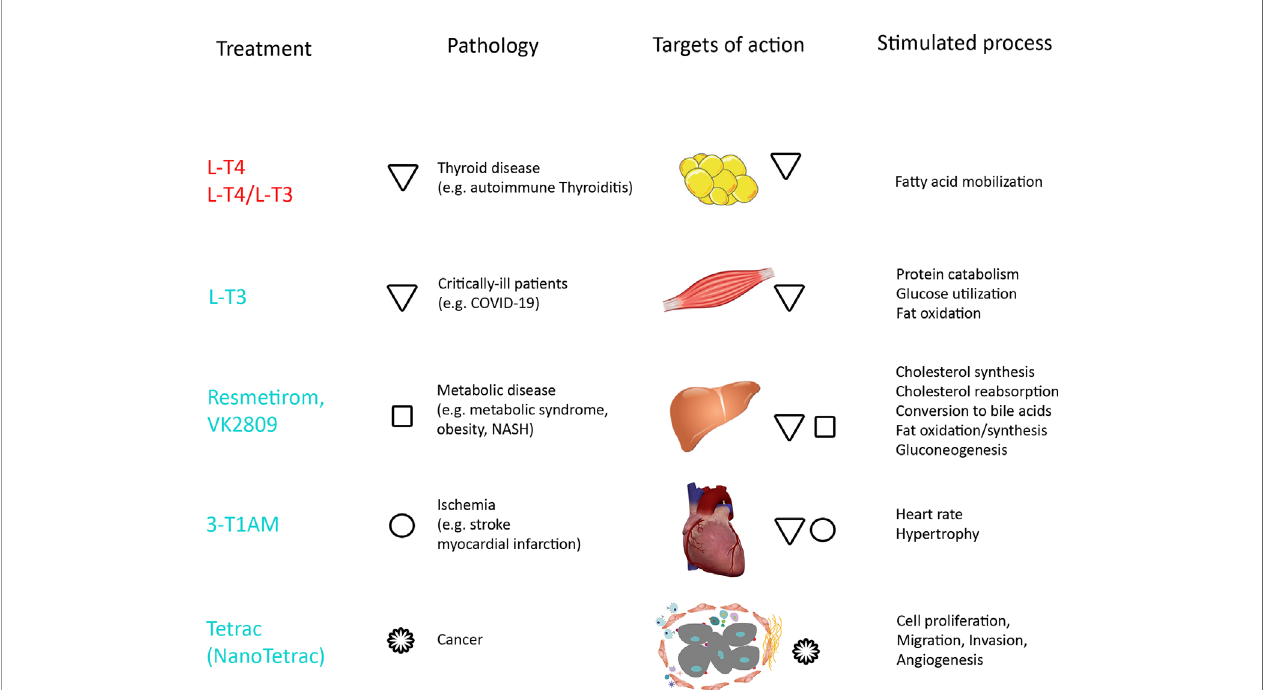
FIGURE 5 | Overview of treatments, pathologies and targets of action with stimulated processes by TH. Tissues relevant for the review are shown and other target tissues like bone, brain, kidney, gastrointestinal tract not represented. Established treatments are written in red, compounds/applications in clinical trials in turquoise. Pathologies and affected tissues are marked by symbols for the compounds (triangles for T3 and T4, squares for Resmetirom and VK2809, circles for 3-T1AM, and rosettes for